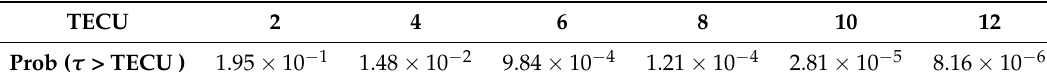
Figure 17. Normalized log frequency histogram of the forecasting RMSE. Table 4. Empirical fraction of values greater than a TECU value